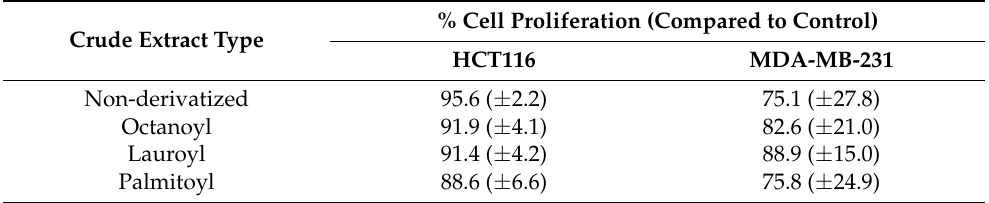
Table 6. Cell proliferation rates of cell lines treated with non-derivatized and derivatized extracts. Crude Extract